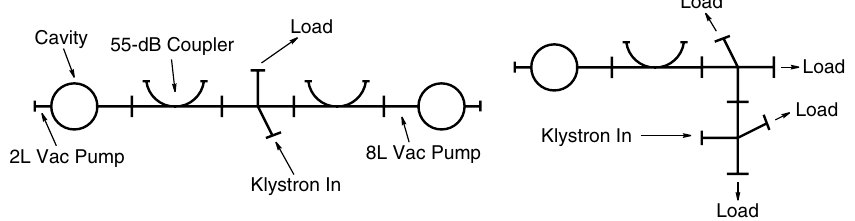
FIG. 8. Schematic of the klystron setups for the first and second high-power